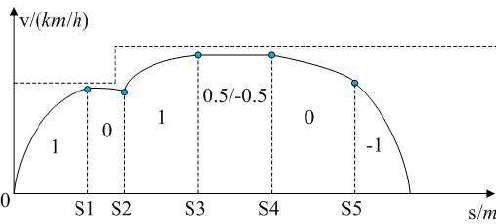
Figure 1. Diagram of train operation mode 1.